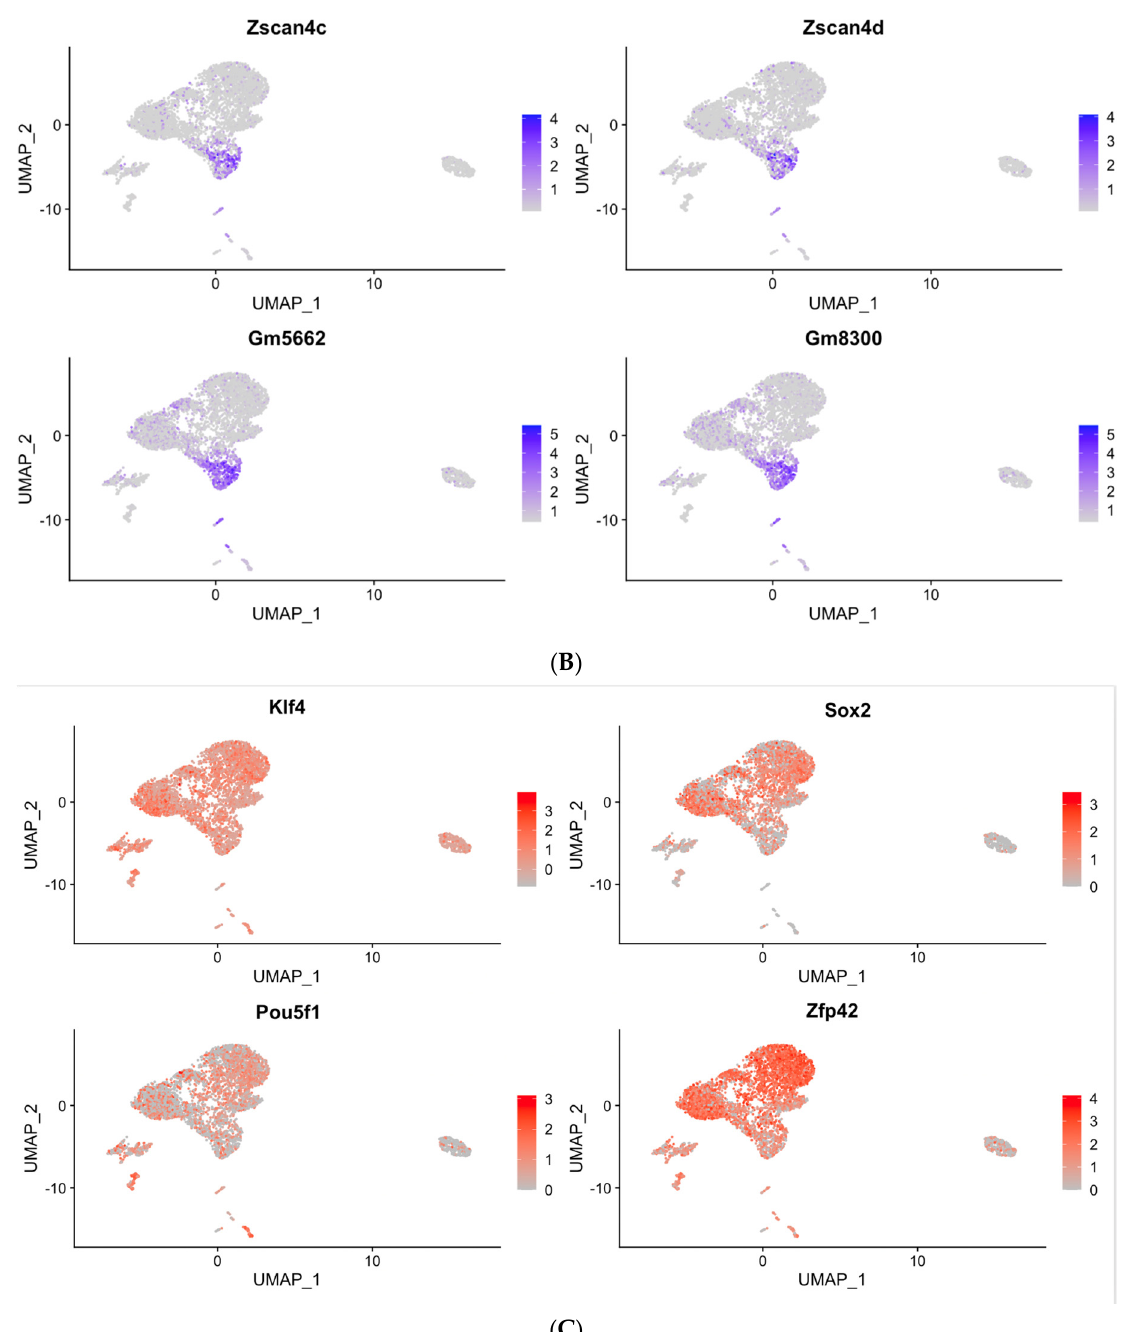
Figure 6. TBLCs clusters and the expression of totipotent and pluripotent gene markers. ( A ) UMAP dimensional reduction plot showing TBLCs clusters and early mouse embryonic developmental stages. ( B ) A feature plot revealing the totipotent marker gene expression on the UMAP dimensional reduction plot. Scale bar represents log-transformed gene expression. ( C ) Feature plot showing the pluripotent marker gene expression in TBLCs clusters on UMAP. Scale bar represents log-transformed gene expression.